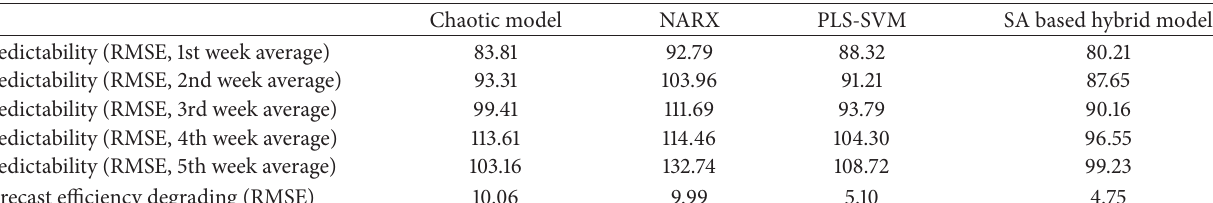
Table 2: Comparison of three models and SA based hybrid forecast. Forecast efficiency degrading means the average degradation of the neighboring week in RMSE.